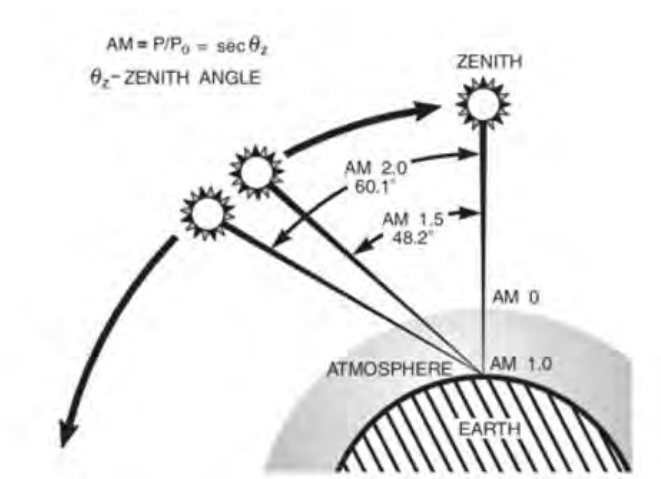
Figure 1. Airmass changes with the zenith angle